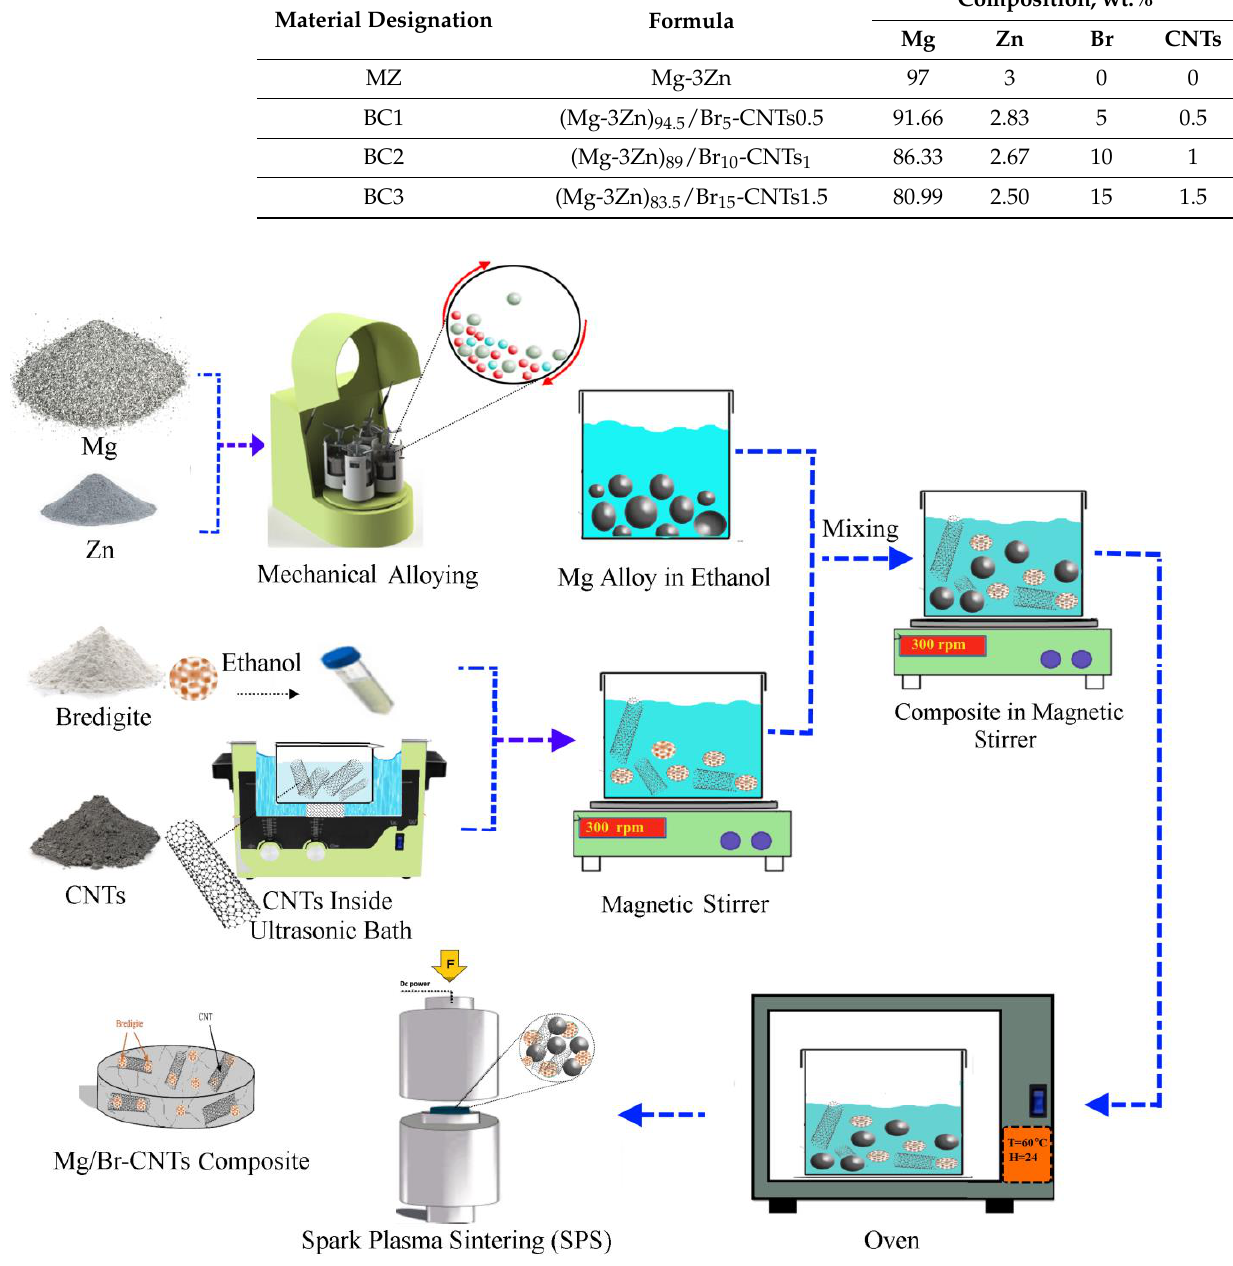
Table 1. Designation and nominal compositions of (Mg-3Zn) x /Br x -CNTs x nanocomposites.